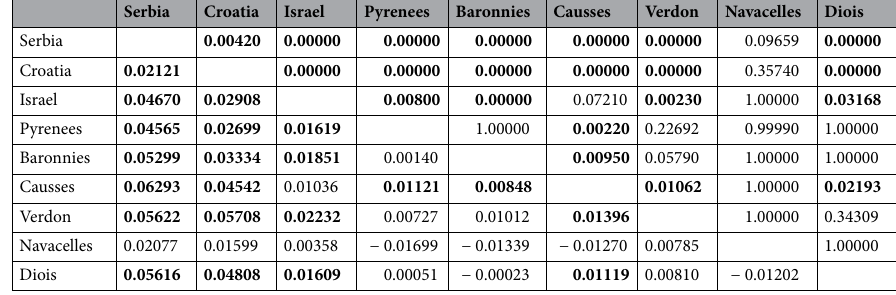
Table 3. Pairwise population F ST (below diagonal) and F ST p values (above diagonal) between the populations based on the variability of 10 microsatellite loci in 9 different G. fulvus populations. Significant F ST values ( p ≤ 0.05; corrected using sequential Bonferroni test) are in bold letters.